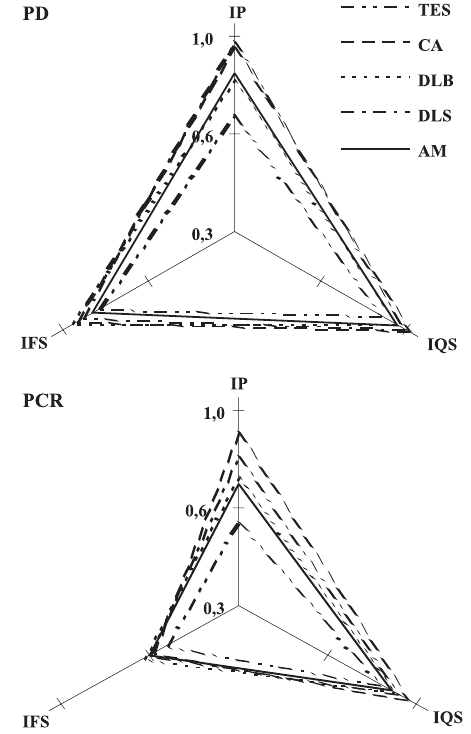
Figura 2. Aspecto técnico do uso de fontes de nutrientes, composto pelo índice de planta (IP), índice químico do solo (IQS) e índice físico do solo (IFS), para os sistemas de preparo do solo plantio direto (PD) e preparo convencional com palha retirada (PCR). Tes: testemunha; CA: cama de aviário; DLB: dejeto líquido de bovinos; DLS: dejeto líquido de suínos; e AM: adubo